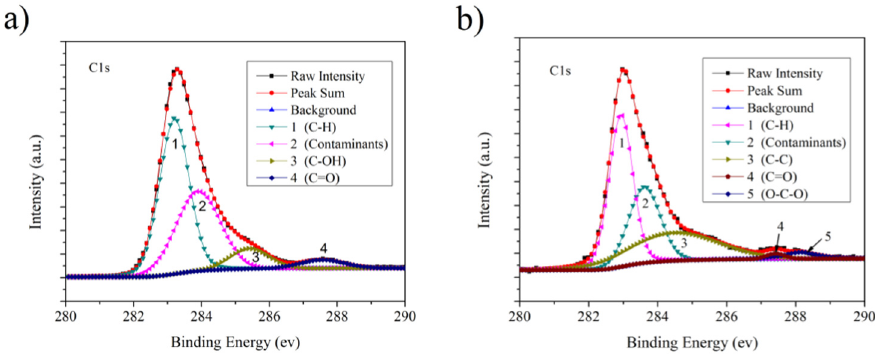
Figure 10. Typical high-resolution XPS spectra of the C1s region of graphene on the sample: ( a ) without annealing; ( b ) with annealing.